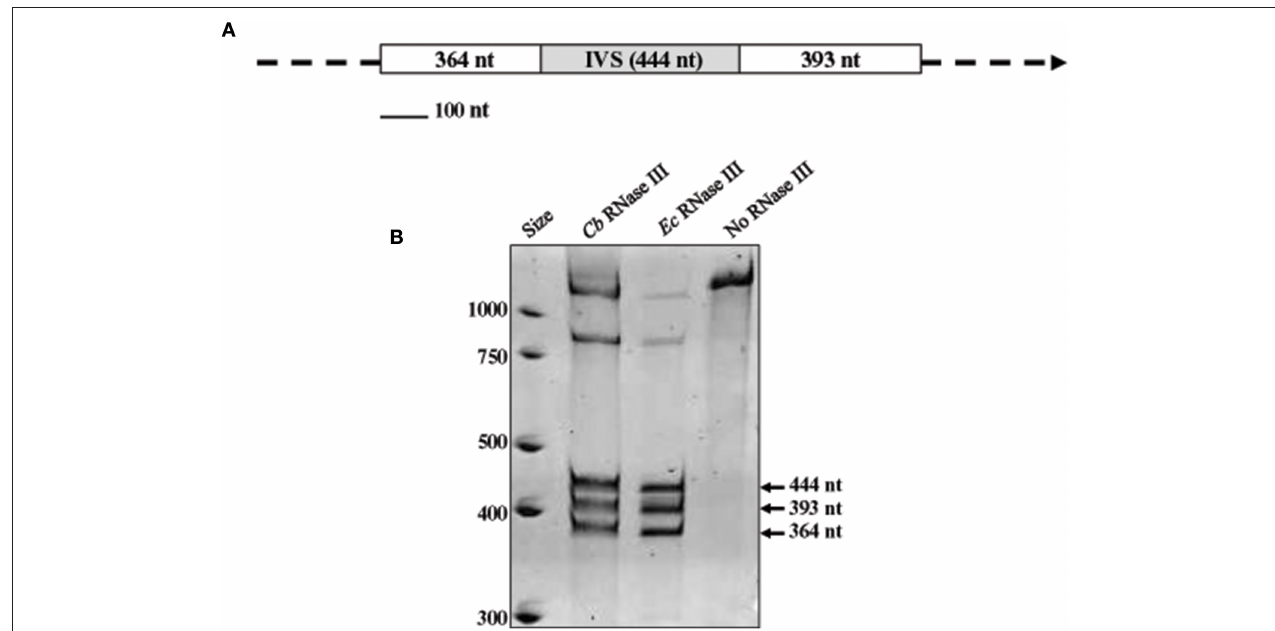
FIGURE 2 | In vitro processing of the IVS by RNase III. (A) Map of the RNA substrate used in RNase III assays, consisting of a segment of 23S rRNA with the IVS (gray box) and proximal flanking sequences (white boxes) with sizes (in nucleotides) shown. (B) Acridine orange-stained polyacrylamide gel [4% acrylamide (w/v)—8M urea] showing cleavage products of substrate RNA following treatment with recombinant C. burnetii ( Cb ) RNase III. Three discrete fragments of sizes corresponding to the substrate RNA (arrowed) were observed. Positive [ E. coli ( Ec ) RNase III (Ambion)] and negative (no RNase III) control reactions are shown for comparison.